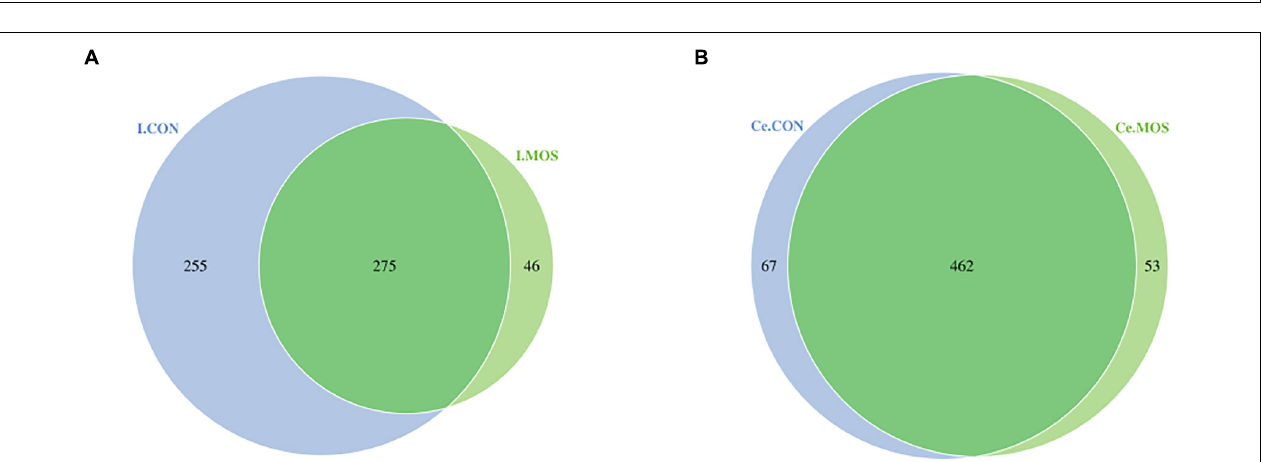
FIGURE 5 | Number of identified OTUs in various comparisons. (A) Venn diagram shows various comparisons of ileal OTUs at the genus level; (B) Venn diagram shows various comparisons of cecal OTUs at the genus level. I.MOS means ileal digesta samples from pigs fed with a basal diet supplemented with 3 g/kg MOS; Ce.CON means cecal digesta samples from pigs fed with the basal diet; Ce.MOS means cecal digesta samples from pigs fed with a basal diet supplemented with 3 g/kg MOS. For 16S rRNA analysis, two digesta samples in each group were pooled ( n = 4).